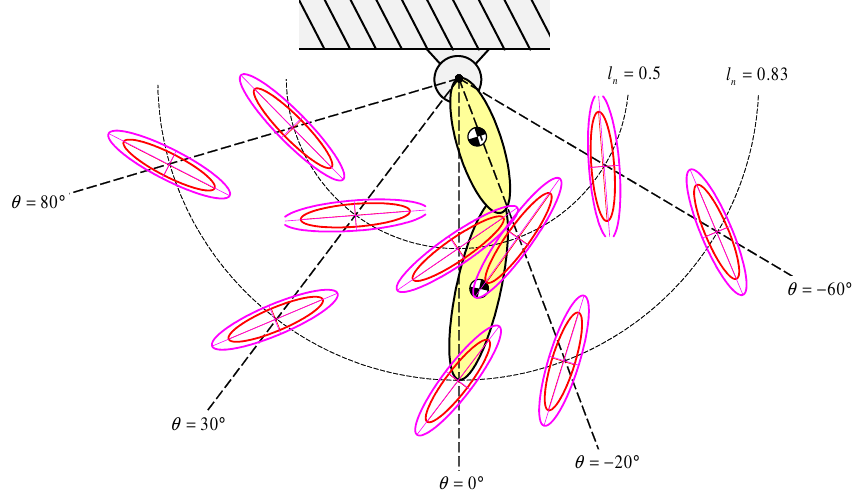
Figure 10. CIEs depending on overall length: l 1 + l 2 (pink) > l 1 + l 2